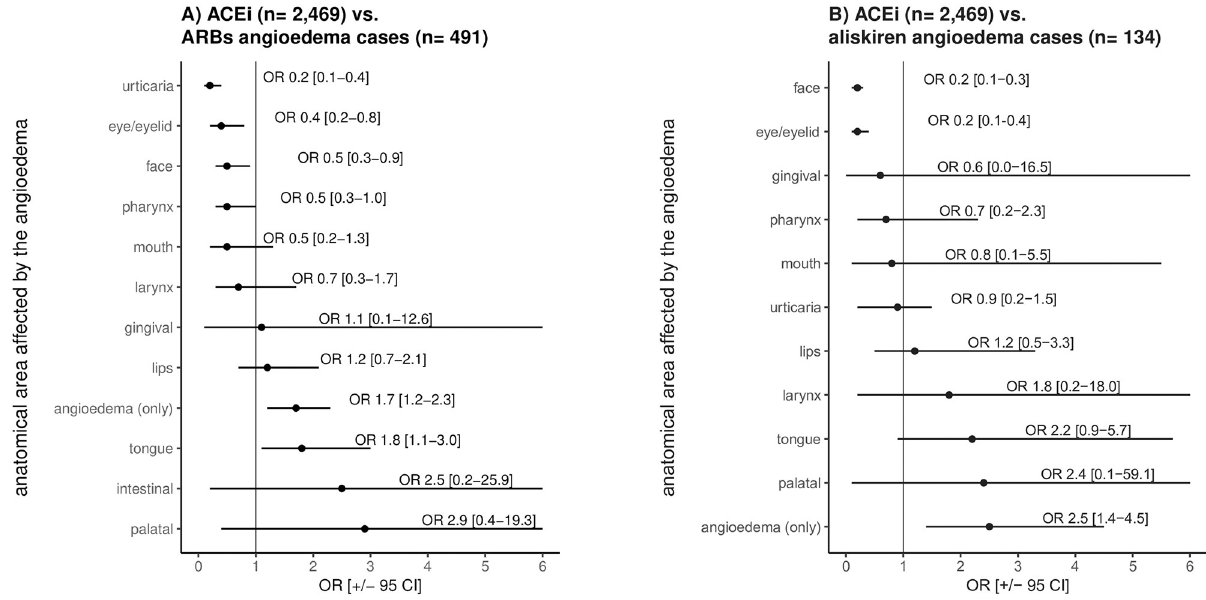
Fig 3. EVDAS analysis: Reported anatomical area affected by the angioedema according to SMQ "angioedema (narrow)" of the MedDRA terminology. � OR = 1 not included. OR > 1 more often reported in ACEi angioedema cases ; OR < 1 more often reported in ARBs or aliskiren angioedema cases